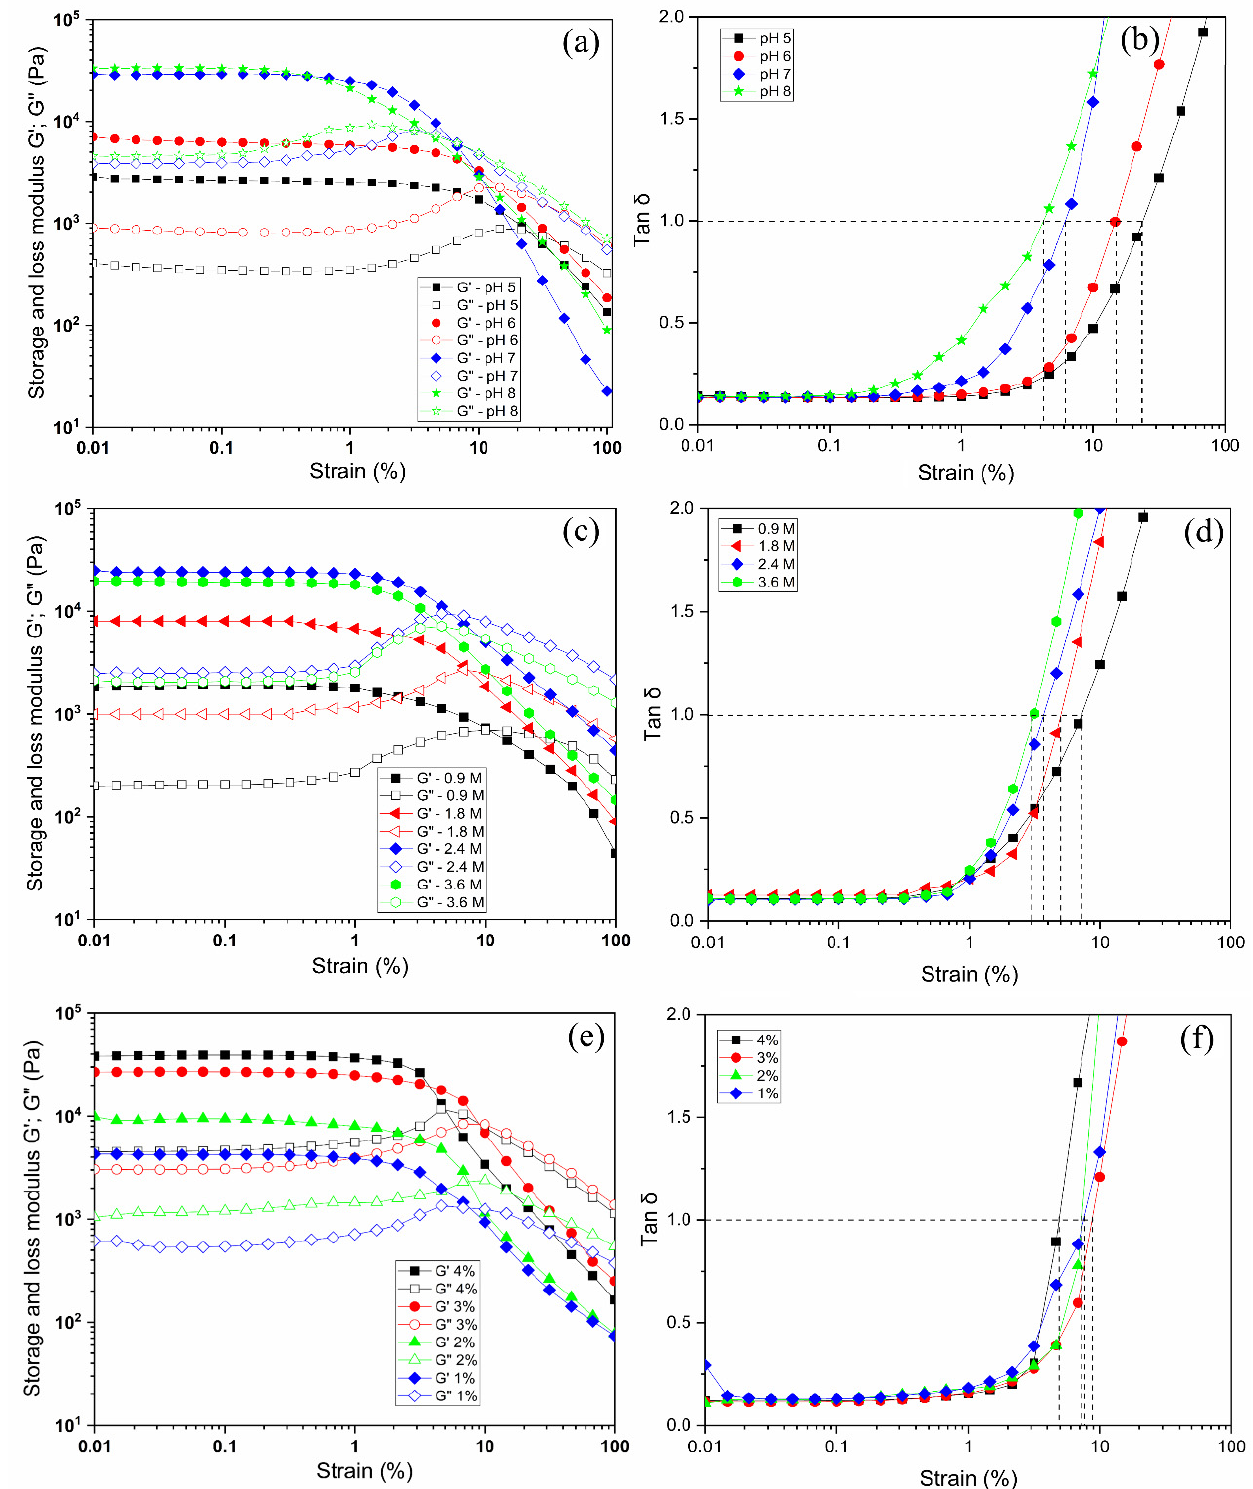
Figure 4. Strain sweep measurements of G’ and G” (left side) and tan δ (right side) for pectin hydrogels prepared at different pHs ( a , b ), various concentrations of calcium solution ( c , d ) for 3% pectin solution at pH 7, and pectin concentrations ( e , f ) for 2.4 M Ca 2+ at pH